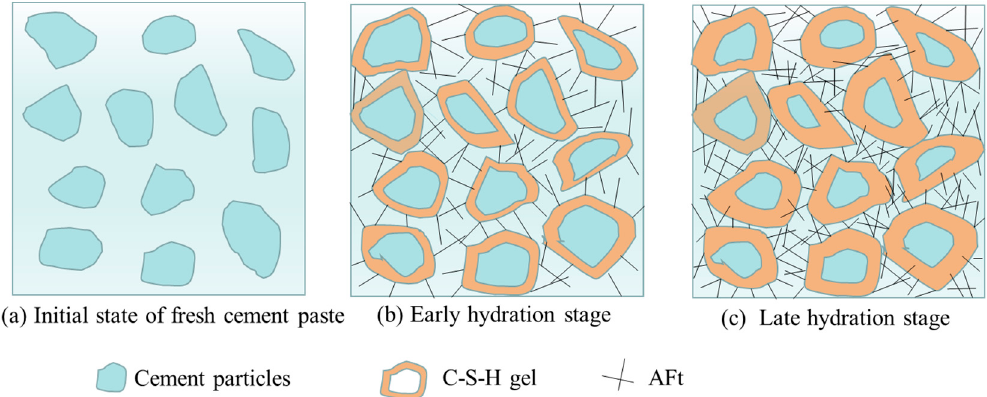
Figure 10. Hydration process of pure cement ‐ based materials.